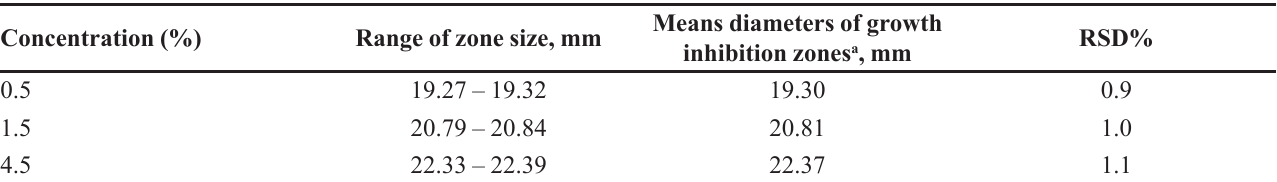
TABLE II - Diameters of the zones of inhibition for CHX digluconate in aqueous solution and the reference solution, obtained using a standard